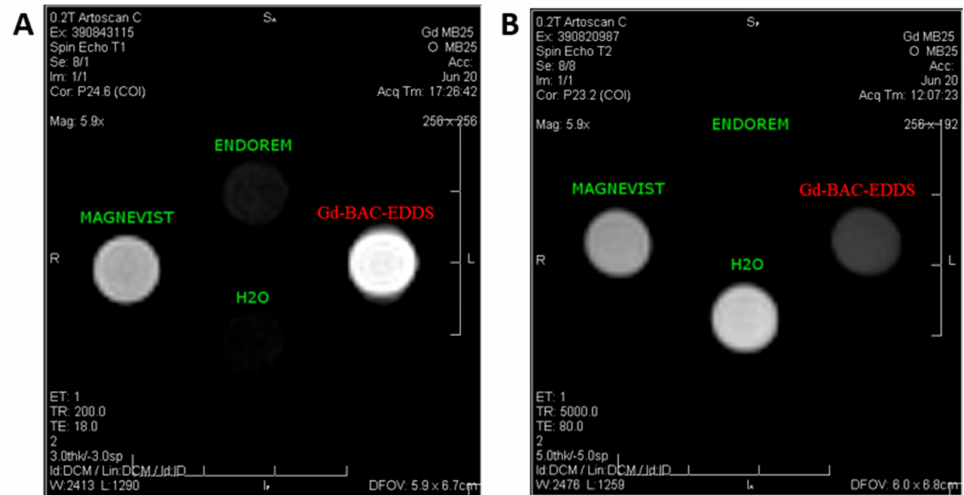
Figure 9. In vitro contrast efficiency of Gd-BAC-EDDS as MRI agent. MRI images of vials containing Gd-BAC-EDDS, Magnevist ® and Endorem ® at the same concentration (~0.85 mM), and ultrapure water, obtained by an Artoscan (by Esaote SpA) imager at 8.5 MHz at room temperature by means of a high-resolution spin echo sequence: ( A ) T 1 weighted and ( B ) T 2